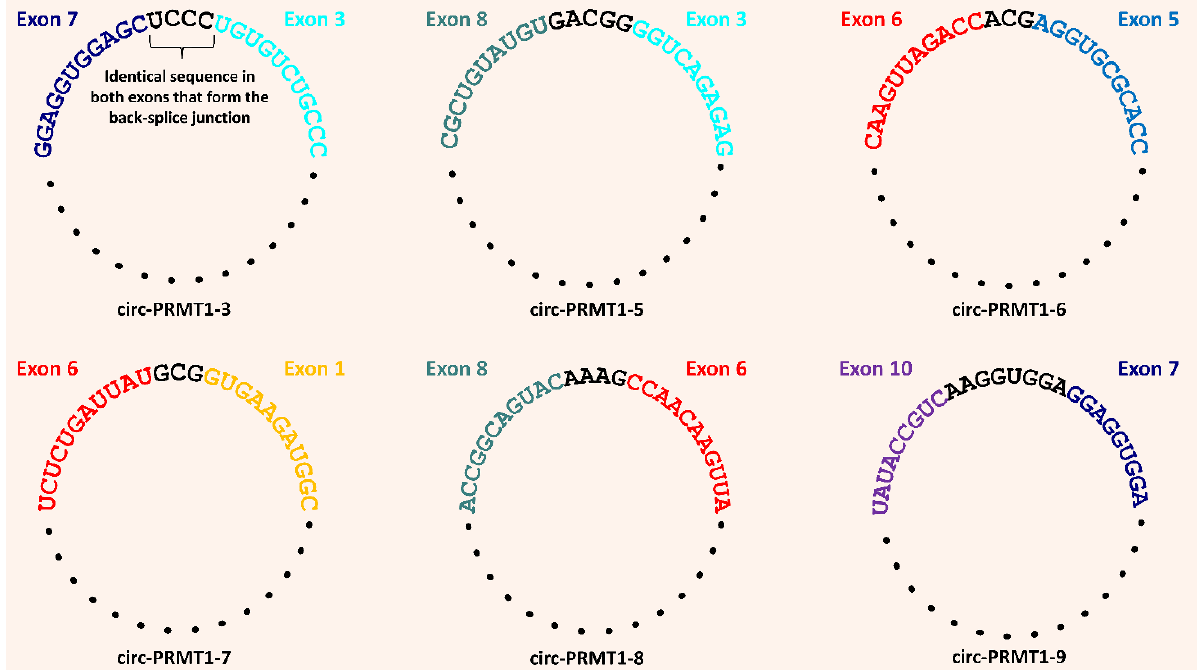
Figure 3. Depiction of the short sequence similarity that was observed in the exon ends that form the back-splice junction in 6 novel PRMT1 circRNAs. These identical sequences that belong at both exons of the back-splice junction are shown in black, while the rest of the exonic sequence is shown in each exon’s distinctive color. Black dots signify the rest of the circRNA sequence that is not portrayed for comprehensibility reasons. The names of the circRNAs in which this feature was observed are found below each circRNA